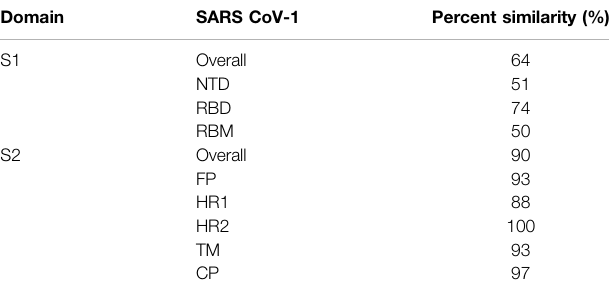
TABLE 2 | Percent similarity of the various domains of the S protein for SARS- CoV-2 in comparison with SARS-CoV-1.